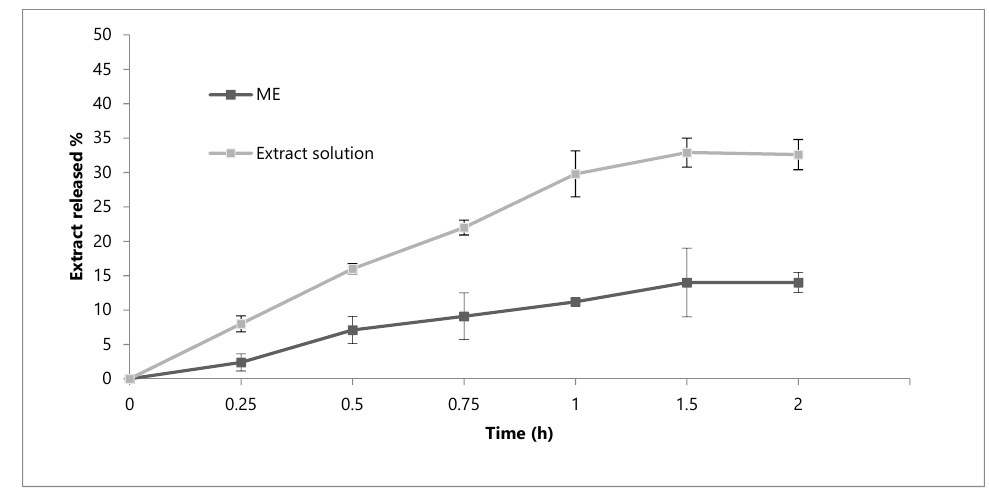
Figure 3. In vitro release profile of phenolic compounds from the OE ‐ ME and OE ethanolic solution in Phosphate Buffered Saline (PBS) medium at pH 7.4. Each value is the mean ± SD of three separate determinations.